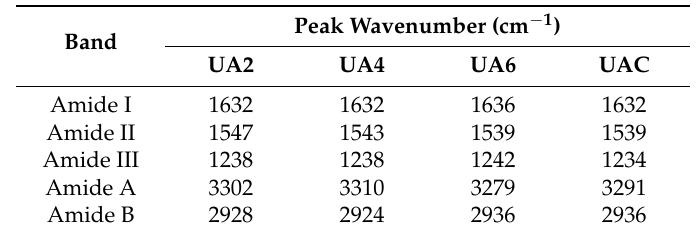
Table 4. FTIR spectra peak position of gelatin samples extracted for the time duration of 2, 4 and 6 h (UA2, UA4 and UA6, respectively) using ultrasound in conjugation with actinidin pretreatment at level 20 units/g of hide. UAC: control gelatin extracted using ultrasound (U) without enzyme